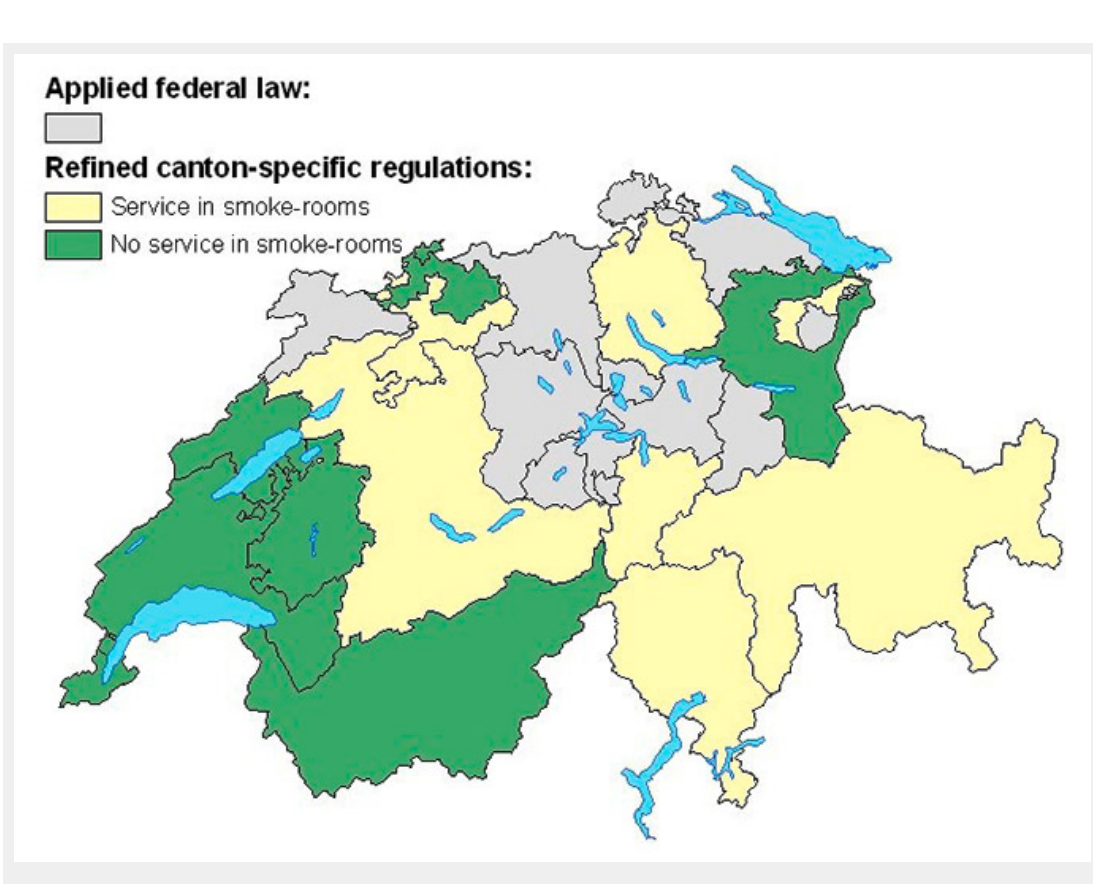
Canton-specific smoking ban regulations indicating application of the federal law (”Bundesgesetz zum Schutz vor Passivrauchen”) (in grey), further regulations covering service in smoke-rooms (in yellow) and no service in smoke-rooms (in